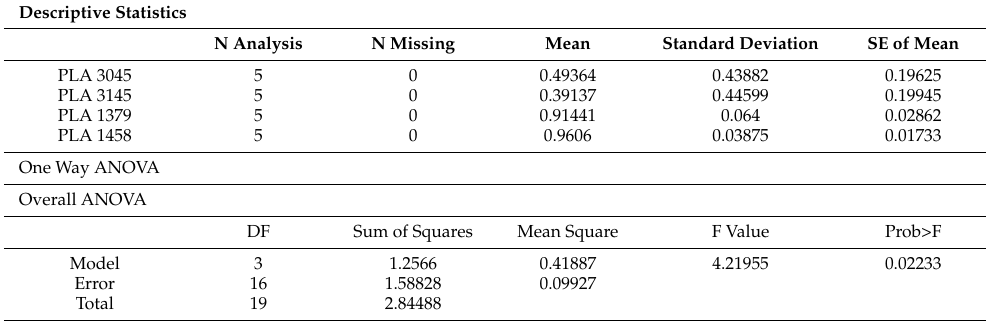
Table 4. One-way ANOVA for PLA samples under UV radiation at 0, 2, 5, 24, and 144 h.